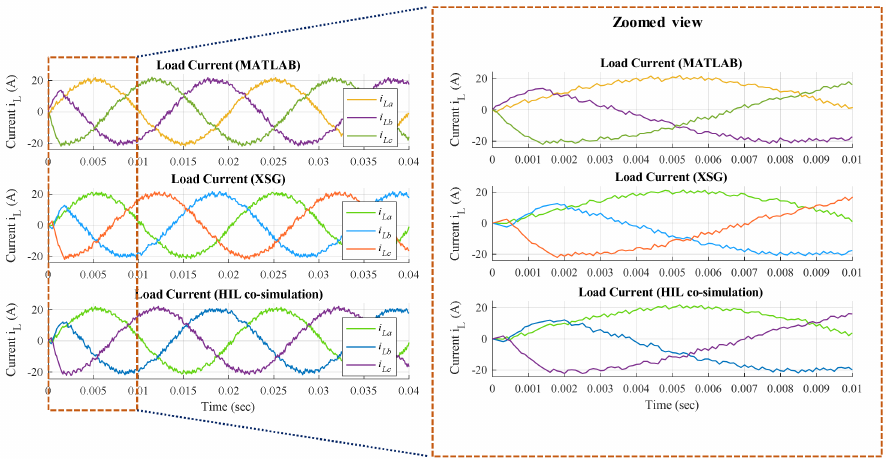
Figure 14. Three-phase load currents obtained using MATLAB/Simulink, XSG, and HIL co-simulation for T S = 100 µ s.